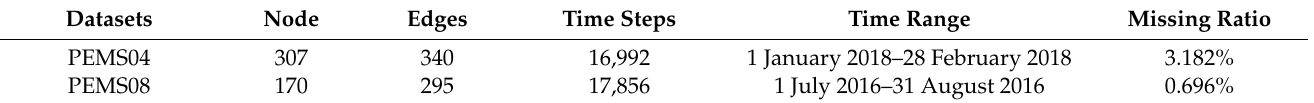
Table 1. Datasets